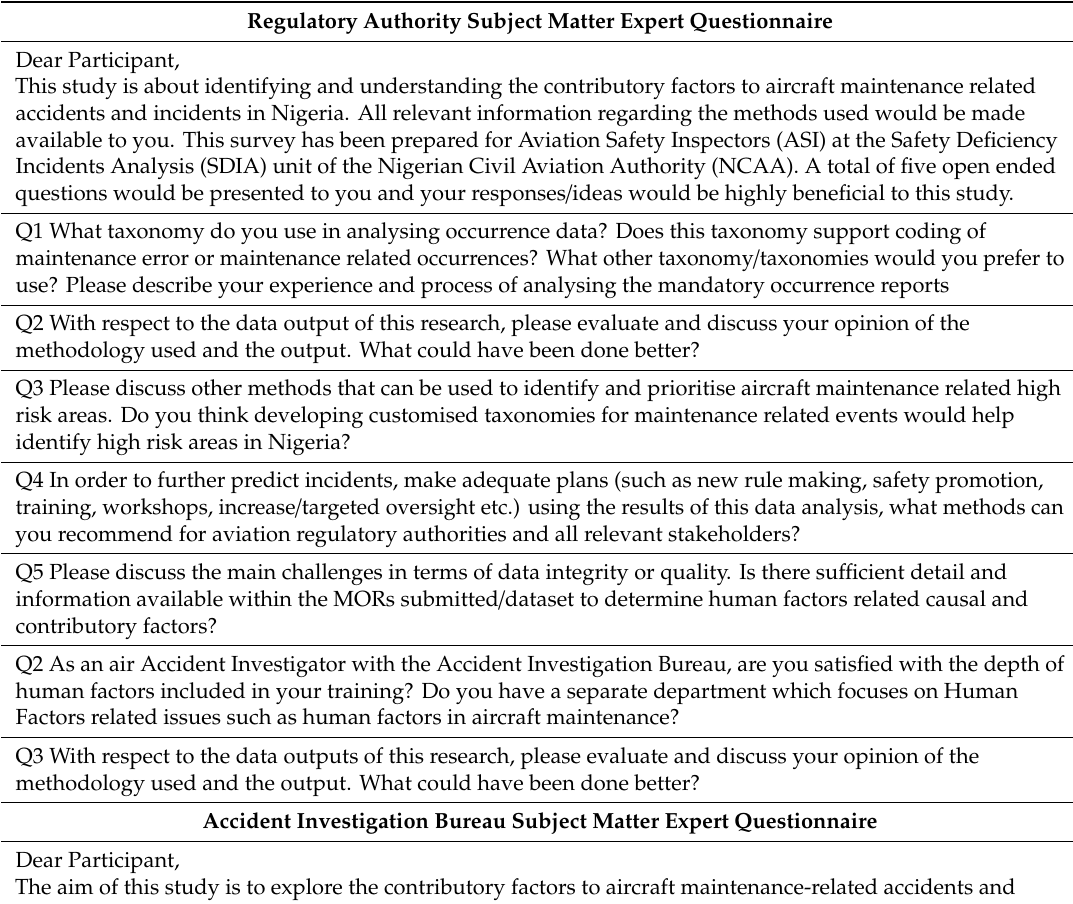
Table A4. Surveys—Subject Matter